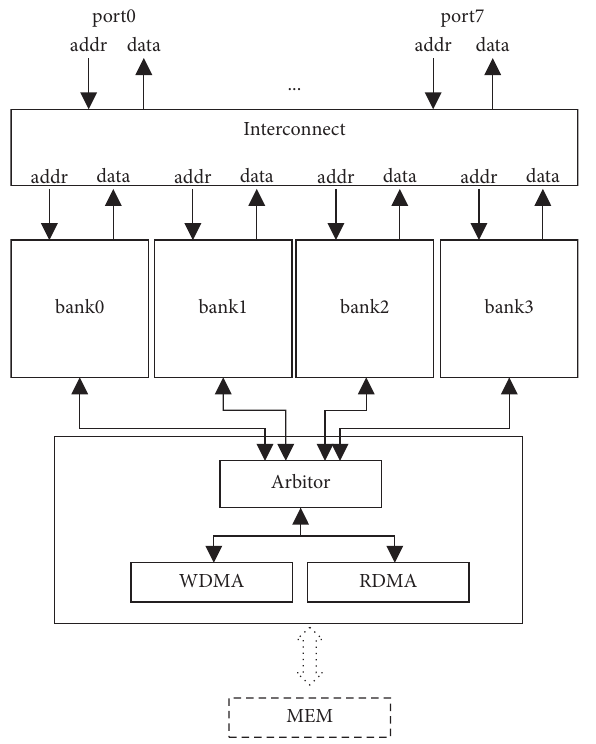
Figure 6: Detailed architecture of the cell